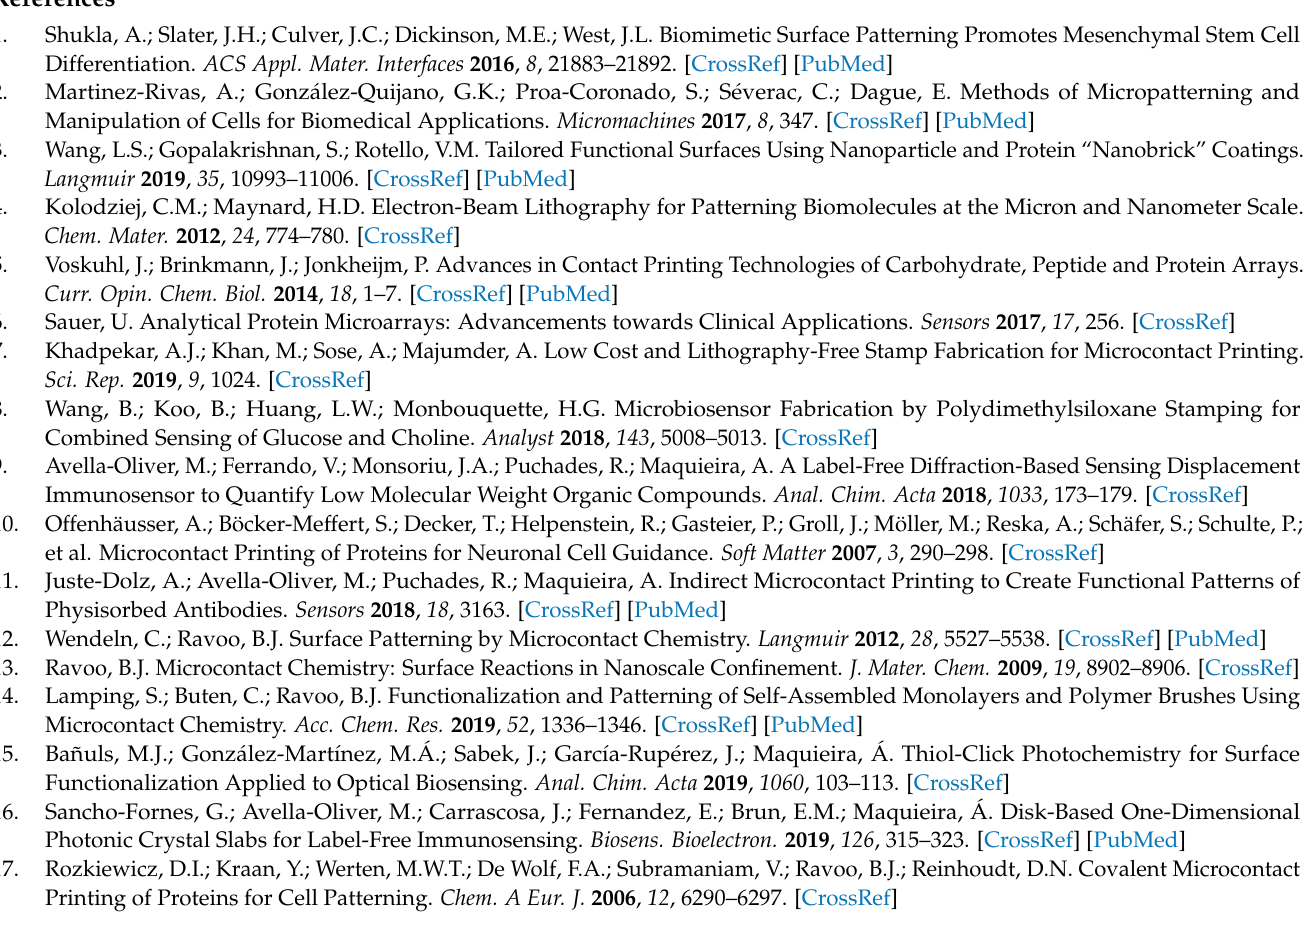
Figure S7. Zoomed view of the low concentration range of both representations in Figure 6 of the main manuscript; Figure S8. AFM images of BSA patterns after incubating a solution of antiBSA in PBS-T at (A) 0 µ g · mL − 1 and (B) 10 µ g · mL − 1 , and (C) the corresponding height of the protein strips measured from these scans; Figure S9. Zoomed view of the low concentration range of the graphs presented in Figure 7 of the main manuscript; Table S1. Characterization results of the PDMS stamps after different ozone exposure times; Table S2. Structural parameters measured from the AFM images in Figure 5; Table S3. Parameters of the linear fittings employed to infer the linear range of the immunoassays (Diffraction efficiency = a + b